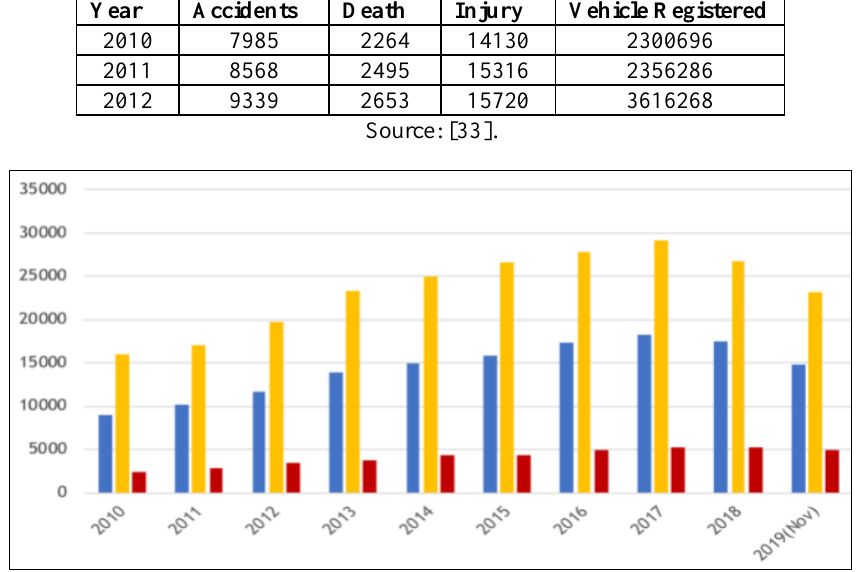
Table 15: Trend of Road Accidents Data (2010~11/2019).